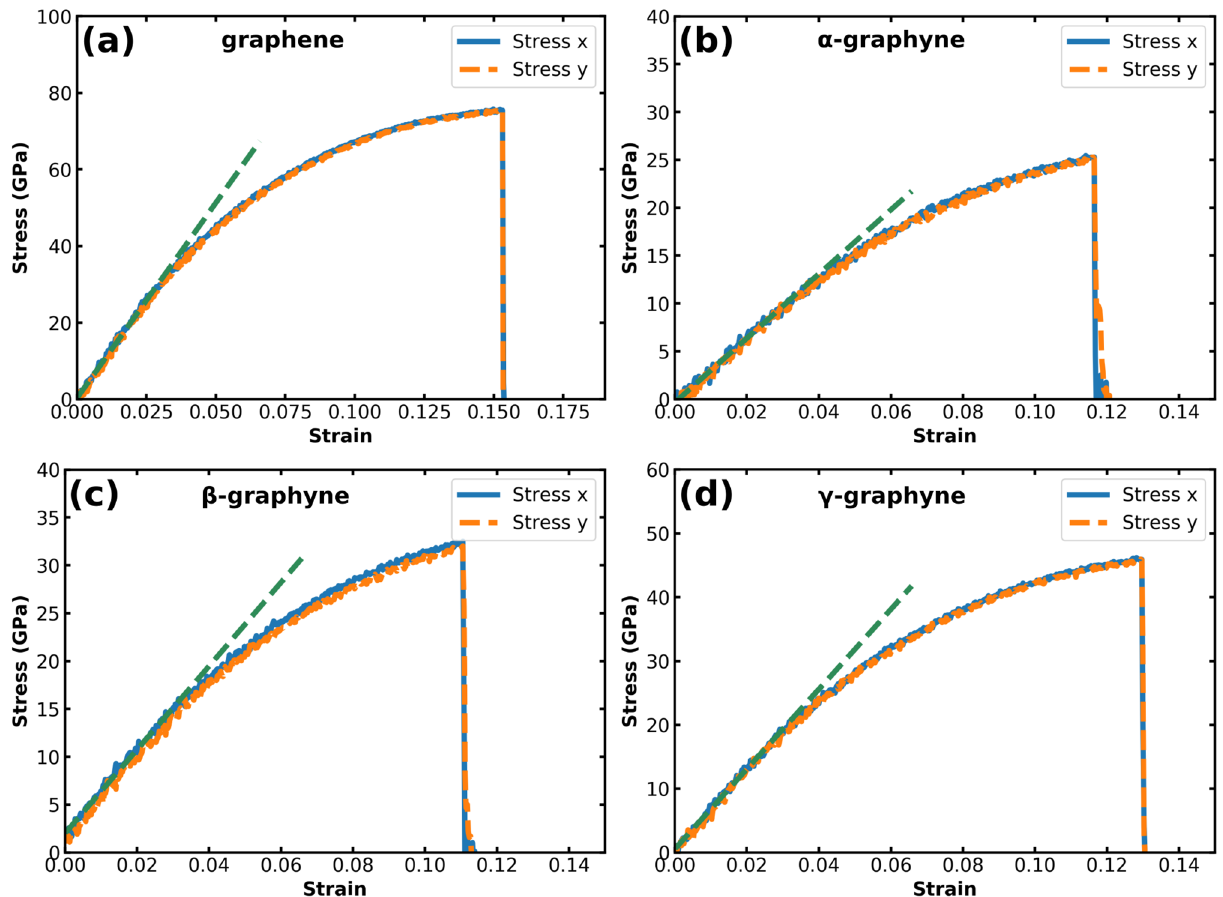
Figure 2. Stress–strain curves for graphene and the three graphynes considered at T = 298 K. We present stress values along both the x and the y directions in this figure. However, notice that stress values are equal for both directions, in accordance with other reports that investigated 2D materials under biaxial strain 56,57 .